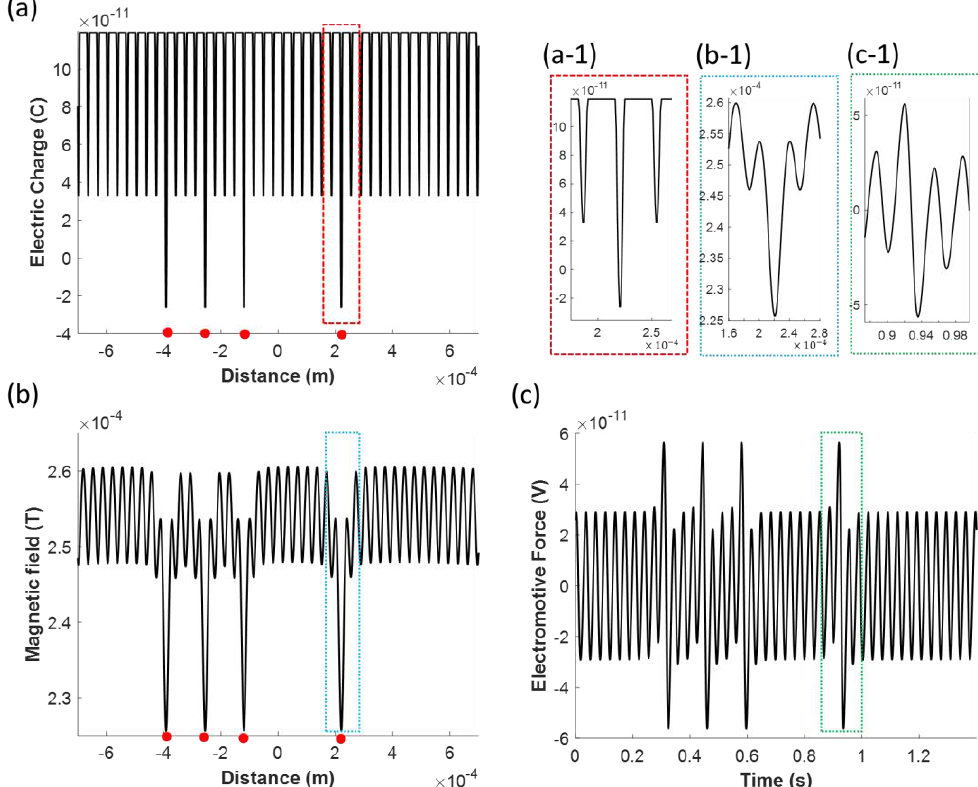
Figure 4. The microcoil can detect and distinguish between RBCs and WBCs. ( a ) Electric charge along the capillary when the WBCs are located at the points indicated by red-filled circles. RBCs are located at the other points along the capillary, while maintaining a constant distance between blood cells ( l BCs ) of 0.034 mm. All the charges inside the base volume, in a capillary with a 1 µ m thickness, are summed to determine the electric charge for each point. ( b ) The magnetic field generated by the moving RBCs and WBCs when the WBCs are located at points indicated by red circles. ( c ) The electromotive force (EMF) measured at the microcoil sensor located just above the capillary. Among peaks, those of greater amplitude are attributed mainly to WBCs, while the smaller peaks are mainly generated by moving RBCs. The electric charge, magnetic field, and EMF are zoomed in to, as depicted in (a-1), (b-1), and (c-1),